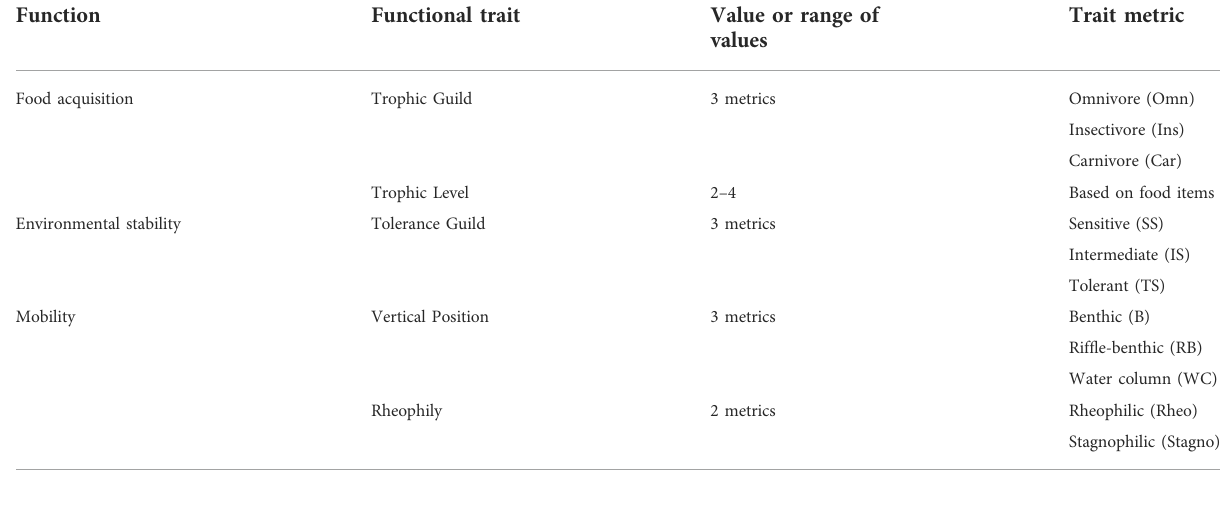
TABLE 1 Fish functional trait metrics used in this study to calculate functional indices.